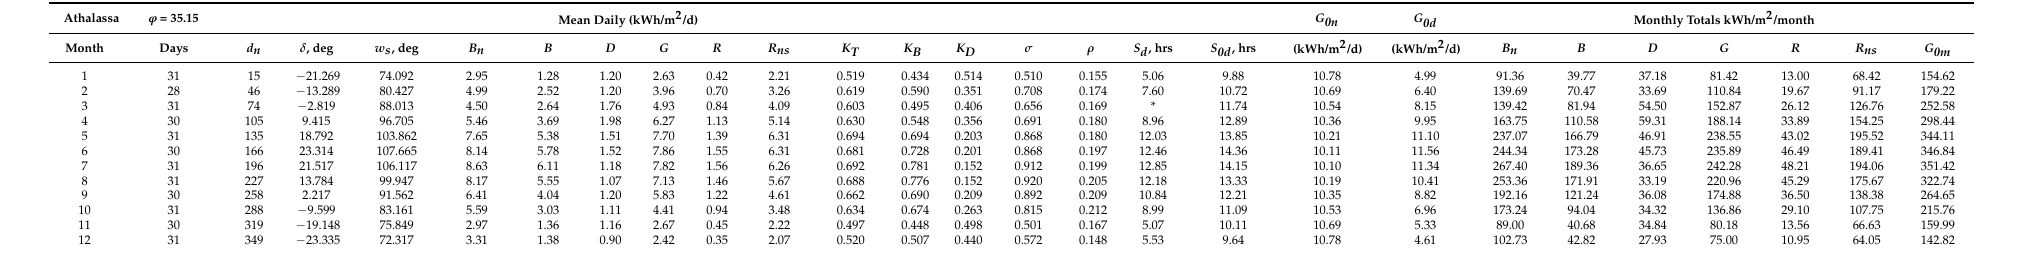
Table 13. Monthly mean daily values which are used to estimate total monthly radiation received by a horizontal surface. The data refers to the mean daily values on the 15th day of each month. Note: * means no records.